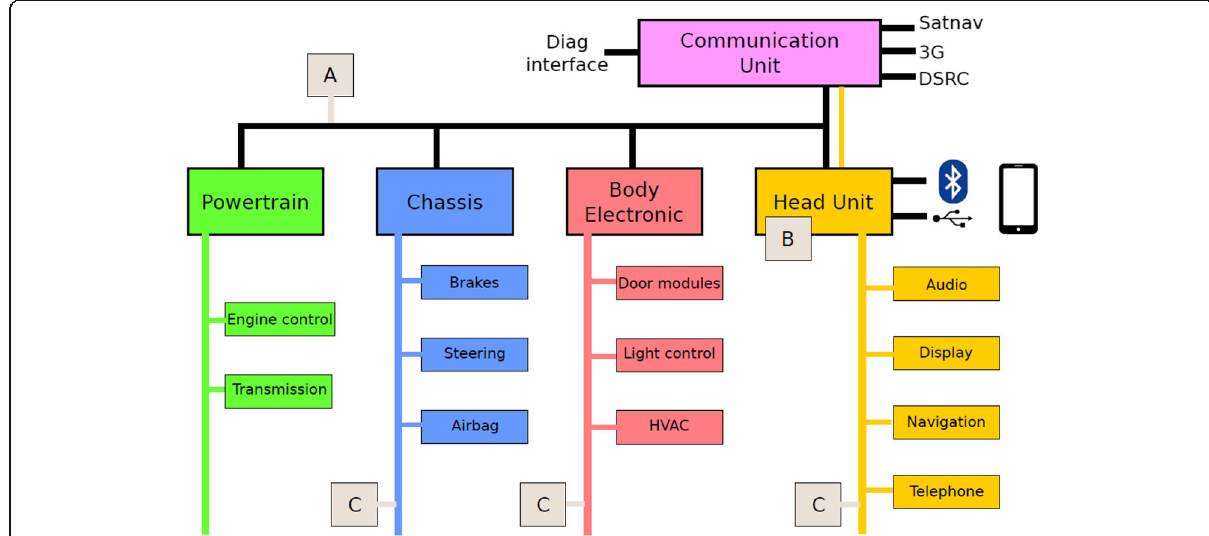
Fig. 4 Possible locations for IDS deployment in the CAN bus system. A) CAN, B) ECU, C) gateways